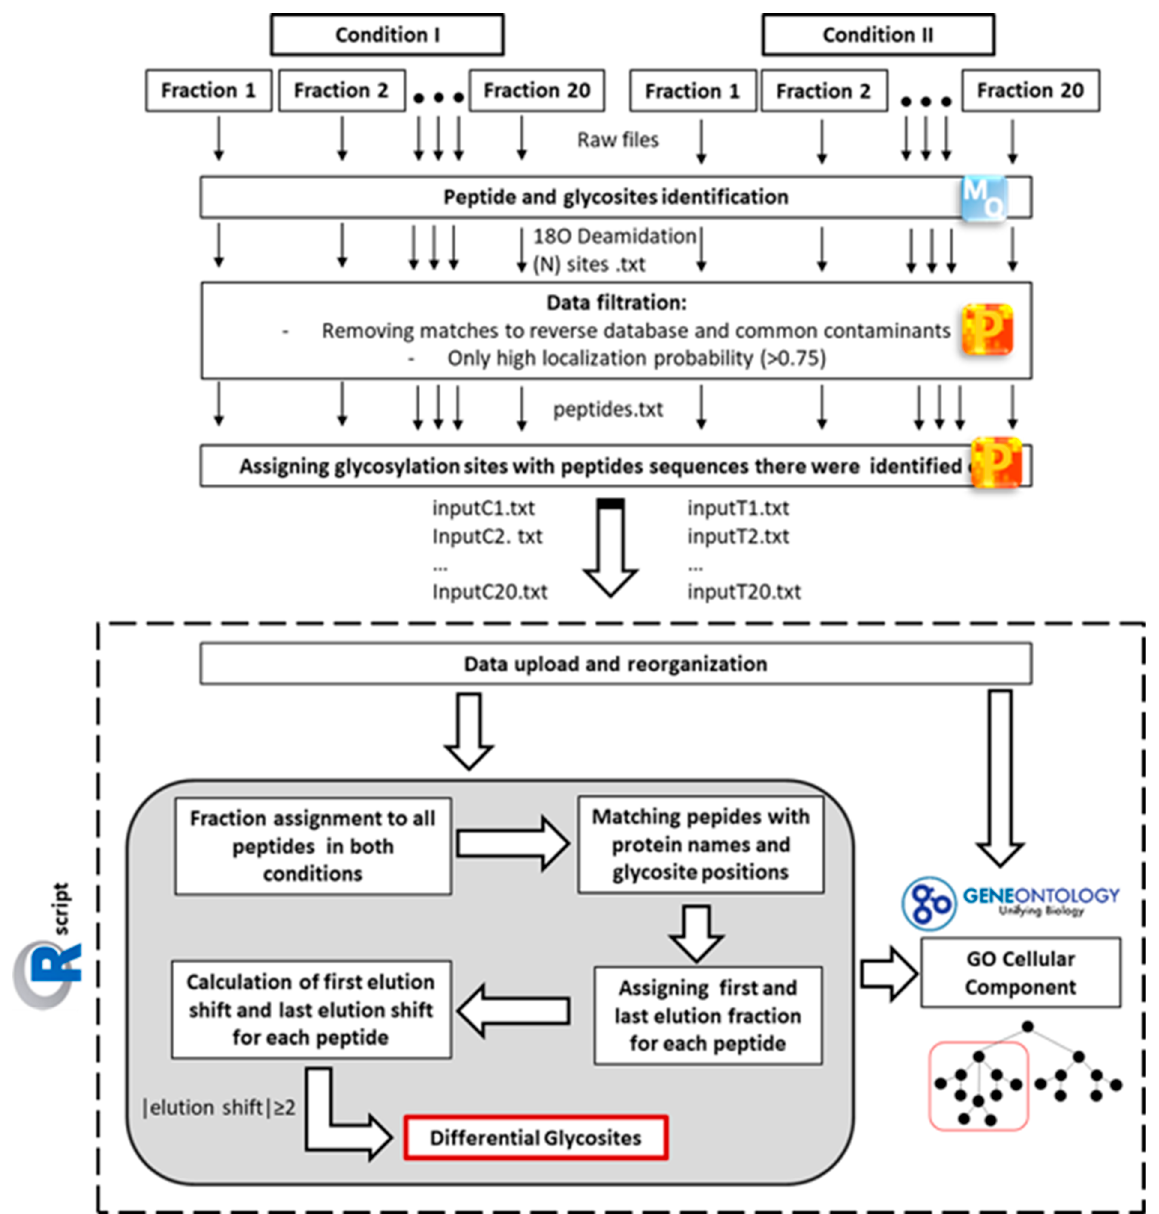
Figure 2. Workflow of mass spectrometric data analysis for differential glycosite profiling. MS raw data from each fraction were separately analysed using the MaxQuant software (MQ). In order to identify glycosites, 18 O deamidation at asparagine was chosen as variable modification. MQ output was firstly filtered for common contaminants and matches to the reverse database. Only 18 O deamidation sites with a high localization probability (>0.75) were considered for further analysis. In order to compare glycopeptides sequences, the identified 18 O deamidation sites were matched with peptide sequence information and the matched data were separately exported as text files for each fraction. For the comparison of two conditions, an in-house R script was used for the data collection, organization, and calculation of elution shifts between the conditions, thus leading to the identification of differential glycosites. Only sites with elution shift ≥ 2 fractions were considered differential. In addition, all glycosites were assigned Gene Ontology cellular component (GOCC) term IDs based on their gene name, which allowed for cellular localization-dependent data analysis.